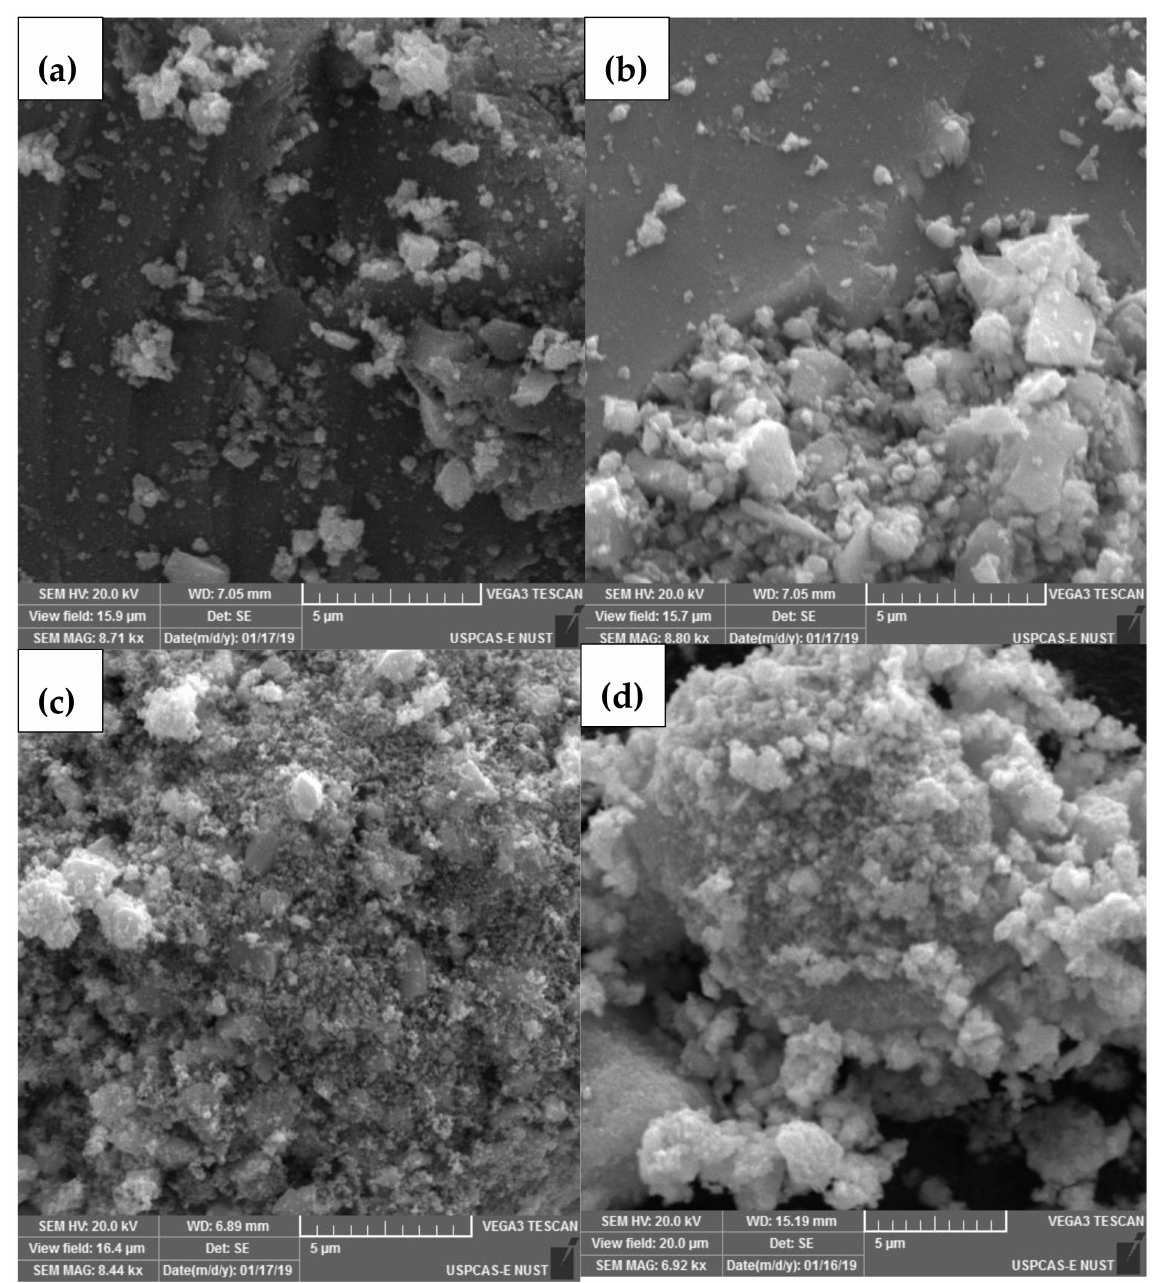
Figure 2. SEM Micrographs of ZnO-ZrO 2 NC calcined at different temperature (( a ) = 100 ◦ C; ( b ) = 300 ◦ C; ( c ) = 600 ◦ C; and ( d ) = 900 ◦